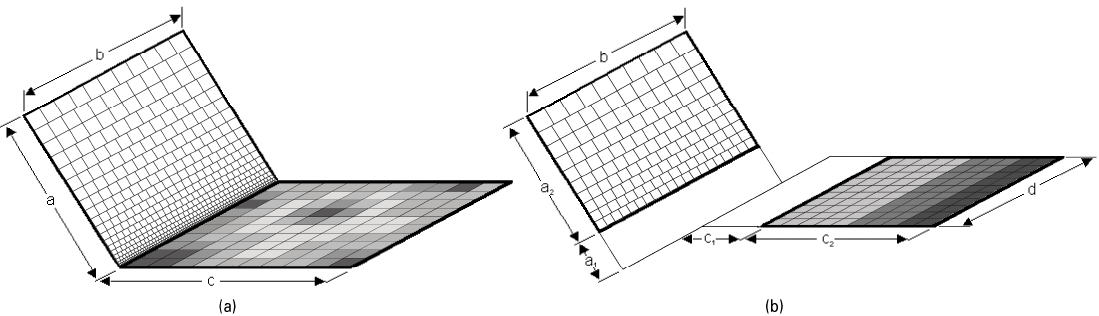
Figure 5. Case with a non-uniform reflecting surface: ( a ) surfaces have a common edge; ( b ) surfaces are non-intersecting. Note that the cells may have different reflectance as depicted by blank, grey, and blackened cells.